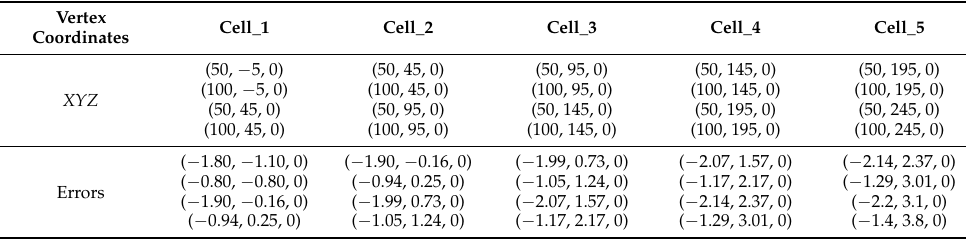
Table 3. Coordinates and errors of cell vertex on vertical